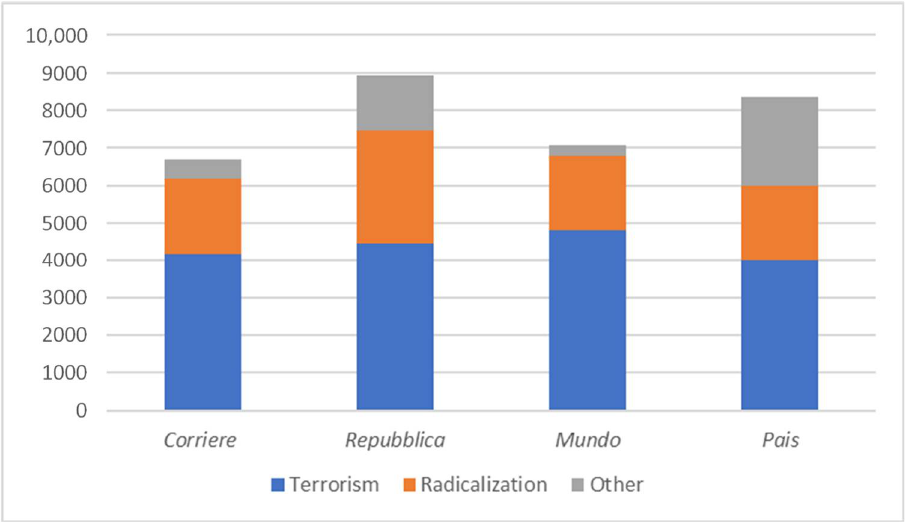
Figure 3. Most recurrent topics. Source: elaborated by the authors. Table 1. Words